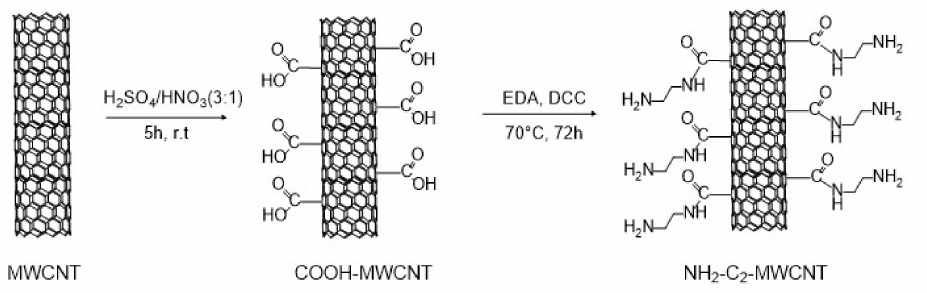
Figure 2. Functionalization of MWCNTs with amino groups.